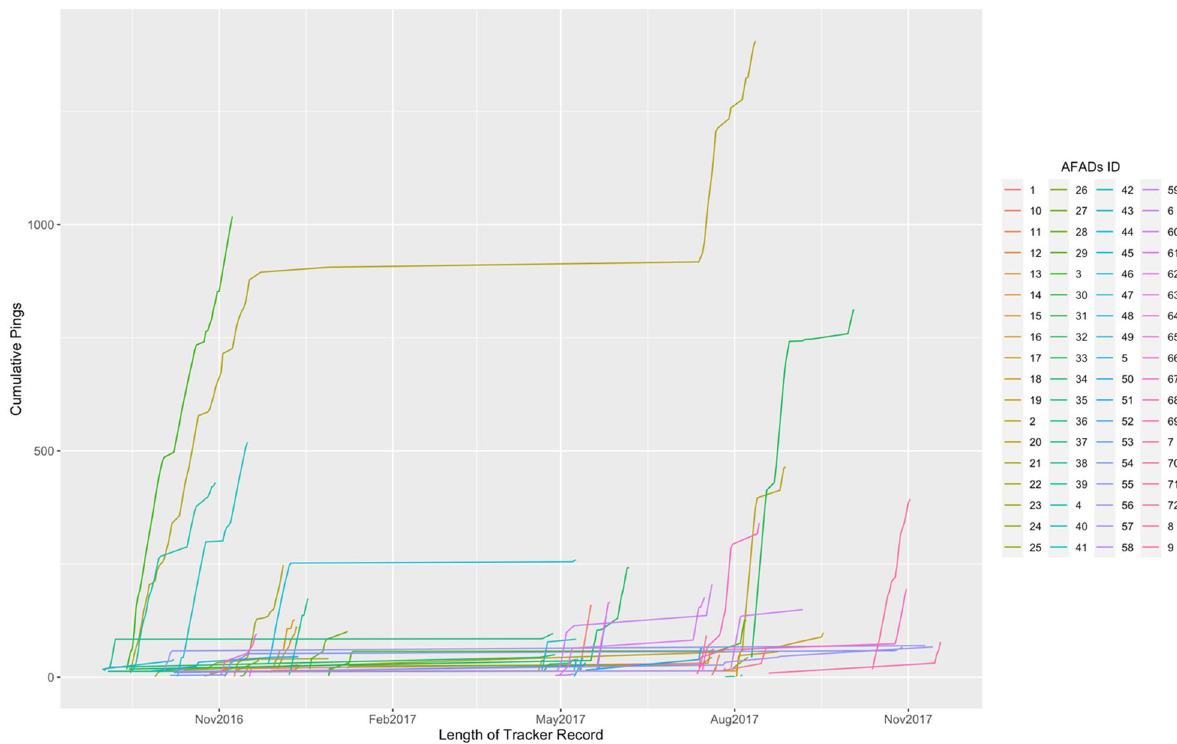
Figure 4. The length of tracker record for each AFAD detected. On the x axis we show the date of the trips, while the y axis shows the cumulative number of ‘pings’ recorded by the Spot Trace device. Colours for the lines indicate different AFADs (as per figure legend).